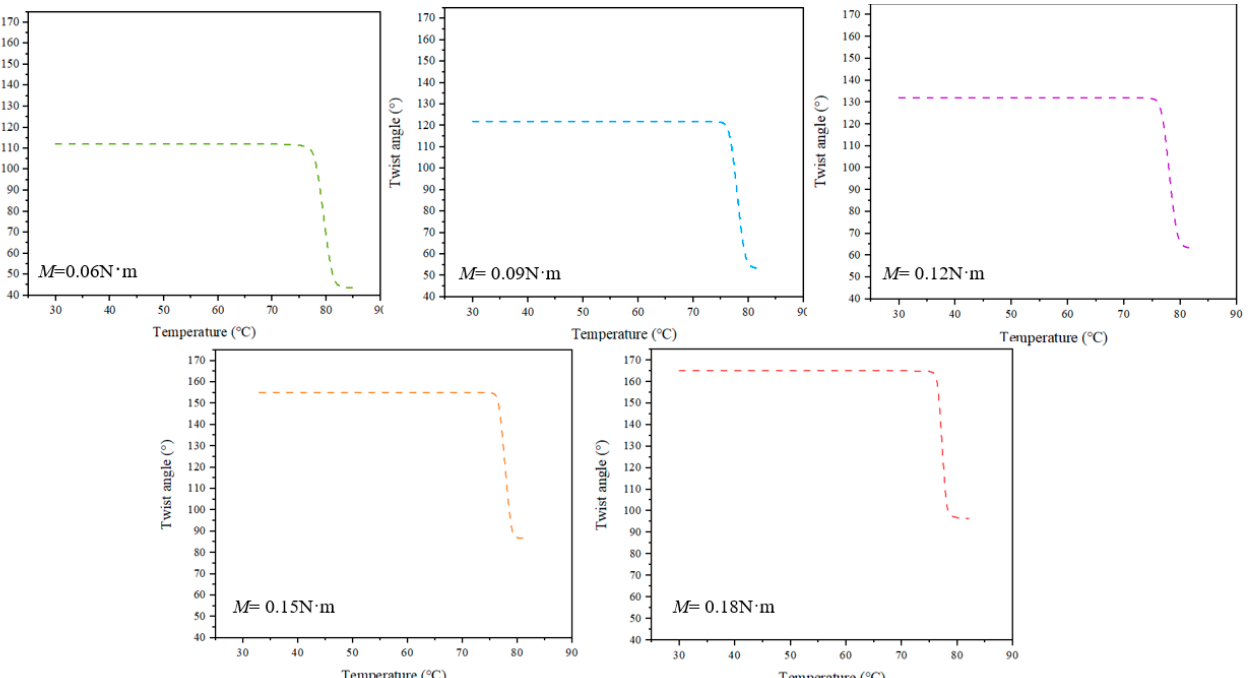
Table 1. SMA material properties.